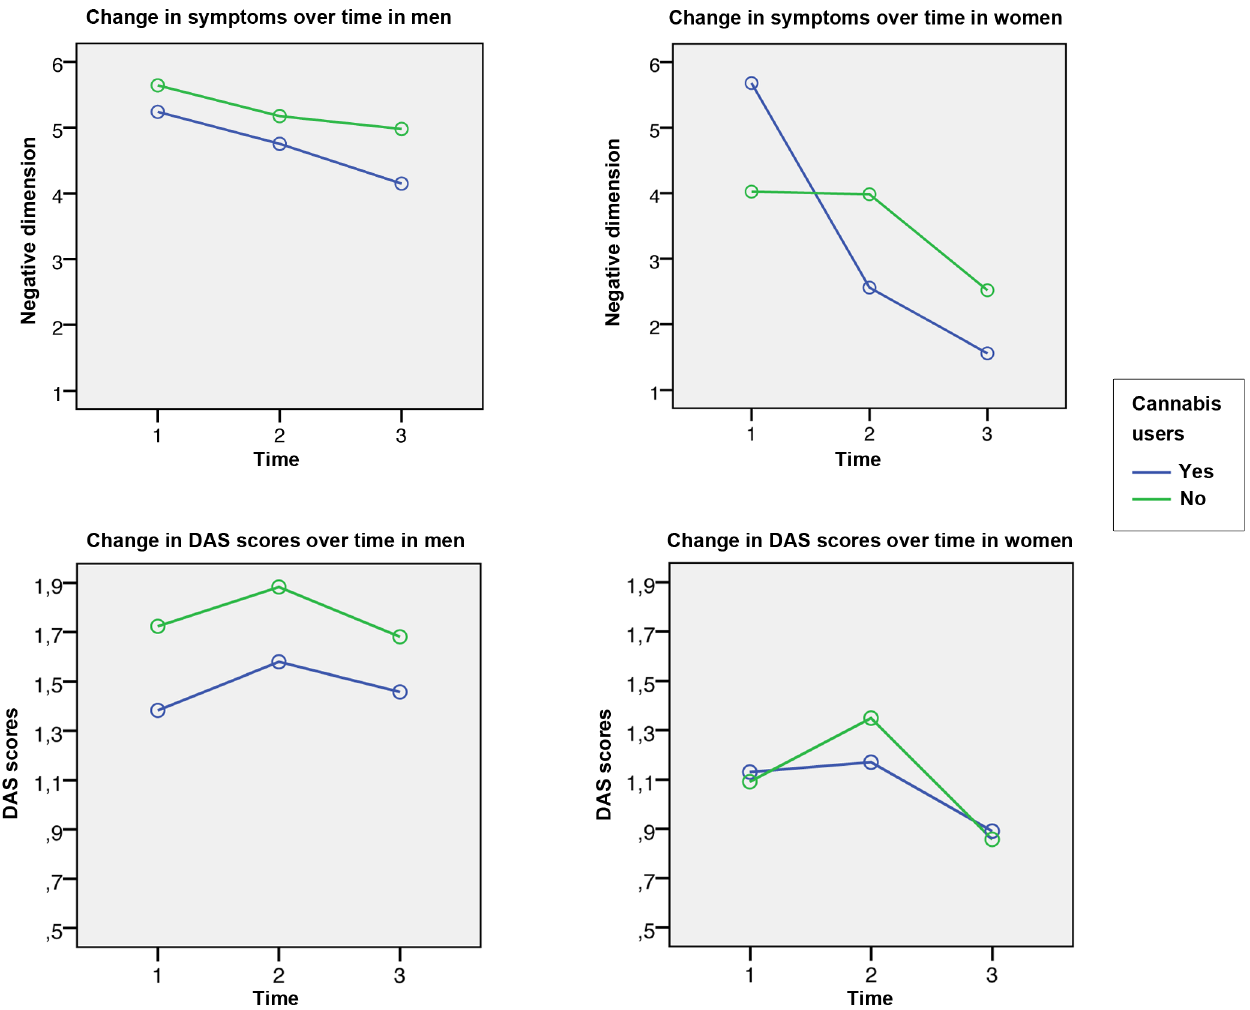
Fig 1. Change in symptoms and functionality over time. DAS: The DisabilityAssessment